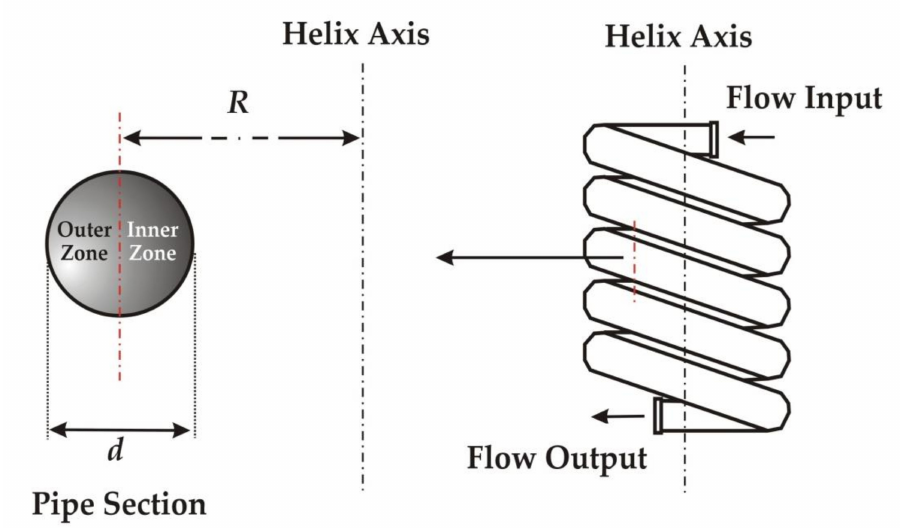
Figure 1. Scheme of a helical separator together with the detail of a section of the tube ( d = pipe internal diameter; R = helix radius).